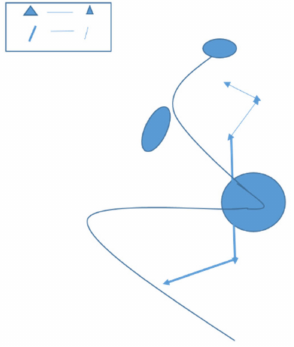
Figure 4. Schematic diagram of the BAS algorithm. The beetle will sense the odor by its two antennas. When the distance between the beetle and the food location changes, the concentration of the smell also changes [47]. By continuously moving and searching for the odor concentration, the beetle can finally arrive at the point of the source. The mathematical modeling for the beetle antenna search (BAS) algorithm can be followed